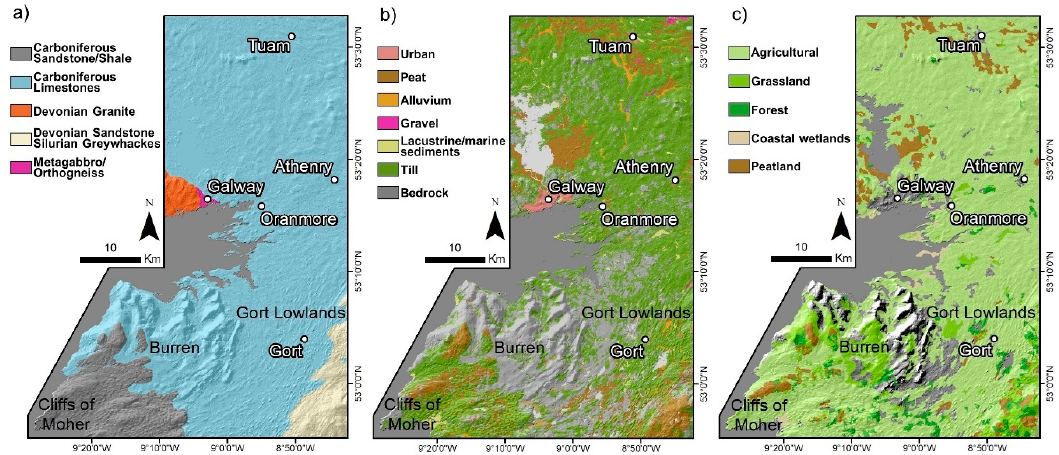
Figure 4. Maps of ( a ) bedrock geology, ( b ) superficial deposits, and ( c ) vegetation land-cover in AOI-1. Boundary data in parts ( a ) and ( b ) are modified from the GSI 1:100,000 bedrock and Quaternary digital geological map series. Data in part ( c ) are modified from the CORINE 2012 land-cover inventory. The base image is a shaded relief map derived from the 30 m Shuttle Radar Topographic Mission (SRTM) digital elevation model (DEM).